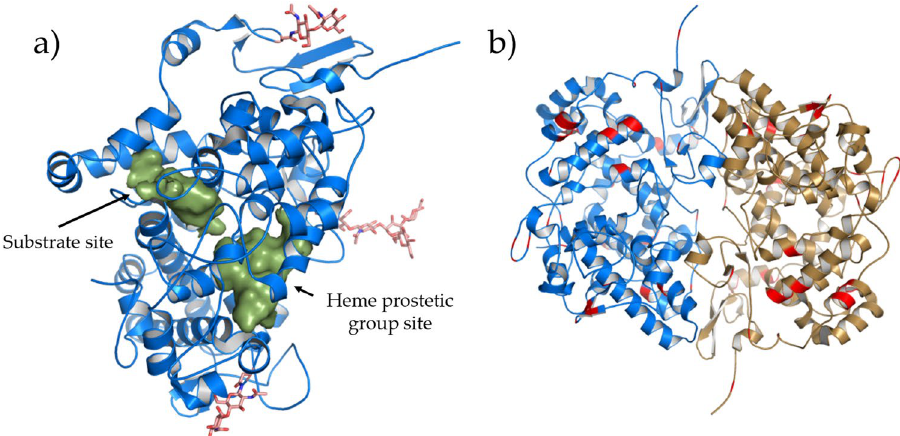
Figure 2. h COX-1 crystal structure (PDB code 6Y3C). ( a ) Asymmetric unit of h COX-1: protein is shown in blue cartoon, and glycosylation along with glycosylation-linked asparagine residues are in pink stick representation. The solvent excluded surface (determined at solvent radius 1.4 Å) of heme and substrate site is shown in green. ( b ) Biological unit of h COX-1: the two protein molecules forming a functional dimer are shown in cartoon representation in blue and sand color. Different residues between h COX-1 and o COX-1 are in red